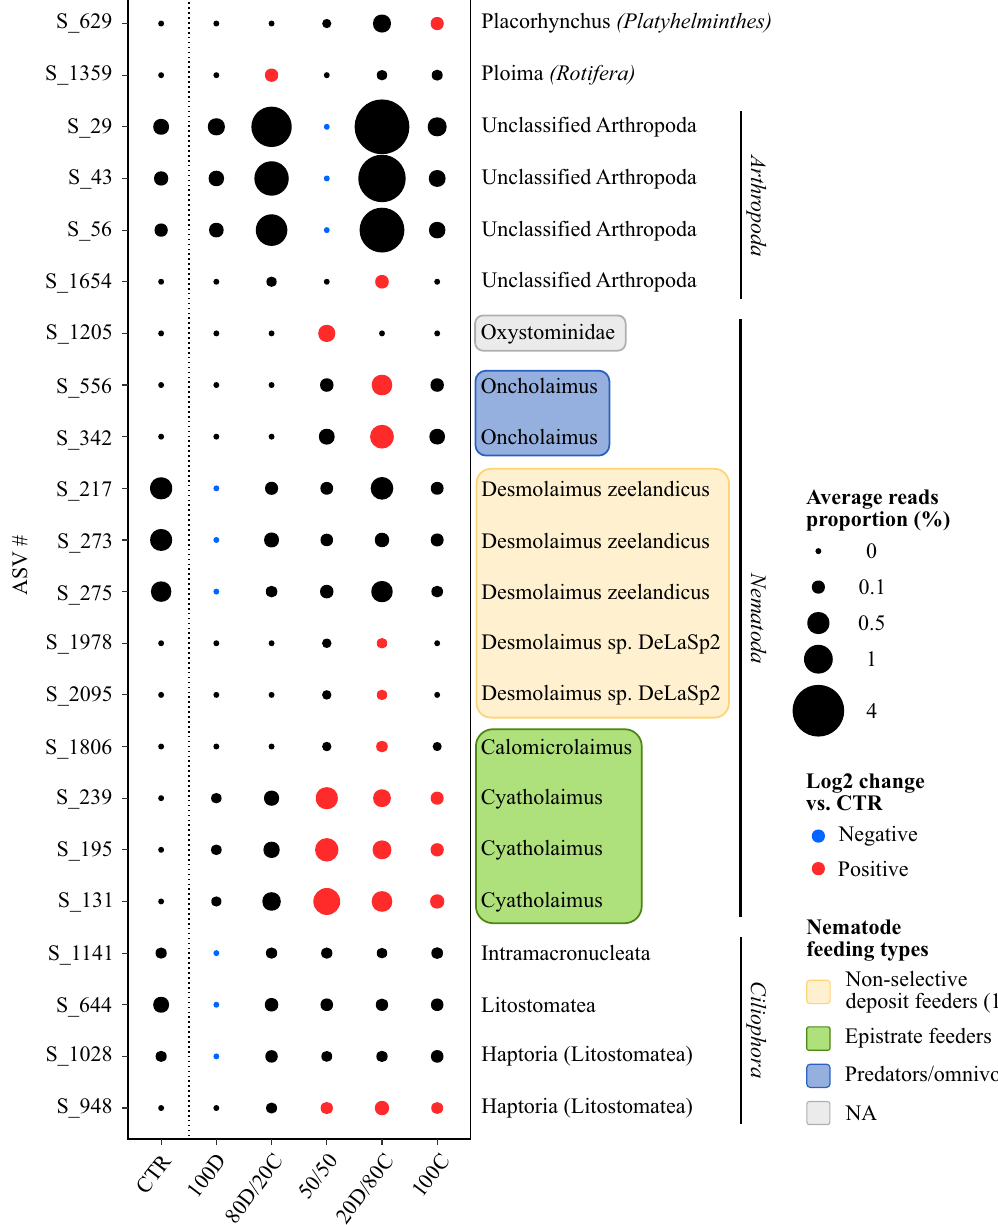
Figure 4. Average relative abundances of 18S rRNA ASVs detected as significantly different in at least one OM treatment compared to control by DESeq2 analysis (increased and decreased abundance displayed in red and blue, respectively. Black bubbles indicate no significant difference compared to control). Unique ASV identifiers are on the left y-axis, and taxonomic affiliation on the right y-axis. The feeding types for nematode ASVs are further indicated by a color-coding. See Fig. 6 for labels on the